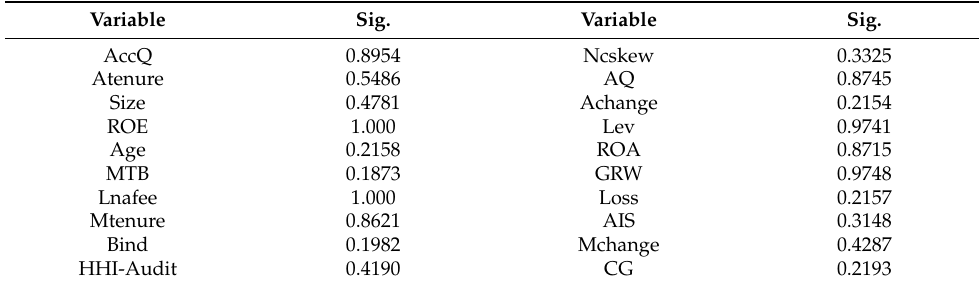
Table 3. The results of the Hadri test.